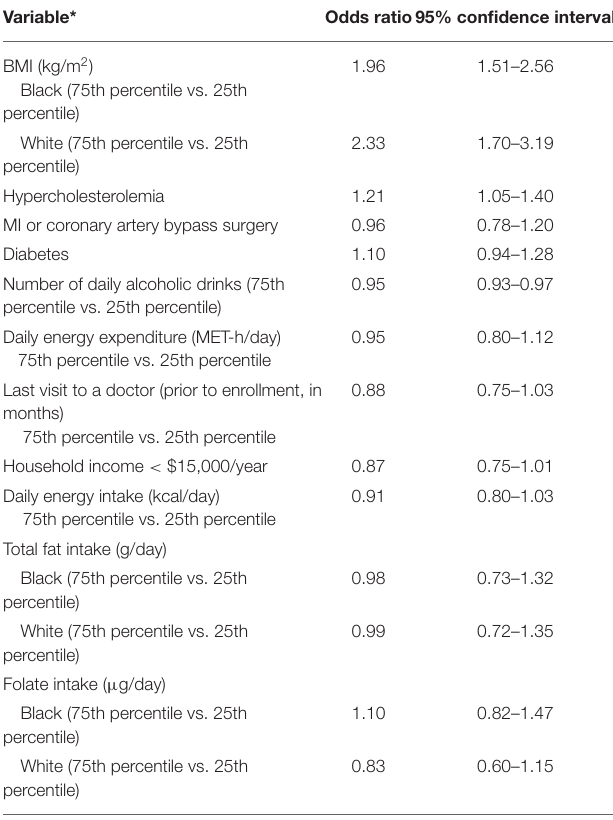
TABLE 2 | Odds ratios (95% confidence intervals) for non-alcoholic fatty liver disease. Variable* Odds ratio95% confidence